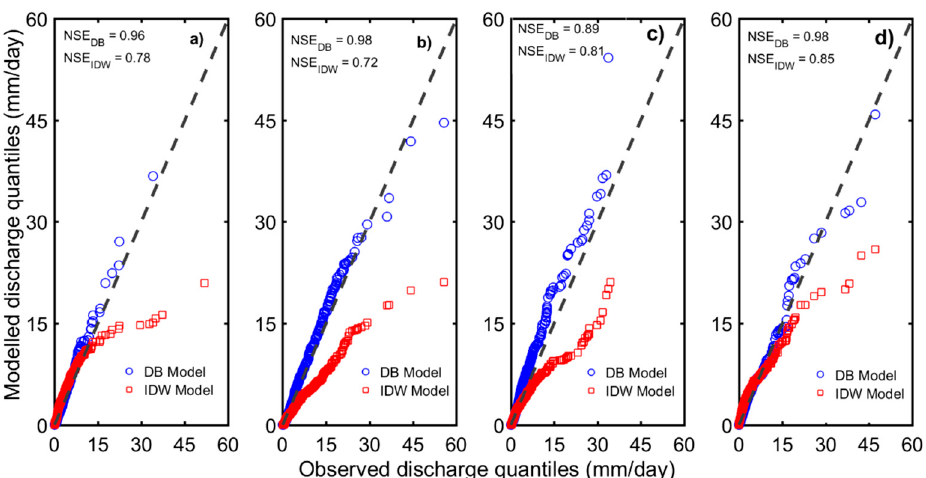
Figure 4. Q ‒ Q plots for the four sample basins: Ambabal ( a ), Honnali ( b ), Jagdalpur ( c ), and Kosagumda ( d ). Observed discharge quantiles and modelled discharge quantiles are compared to evaluate the two models (the DB and the IDW) in terms of NSE. The four representative plots in the figure give an overall comparative assessment of the two models for the entire study region—the DB model is generally more reliable than the IDW model.